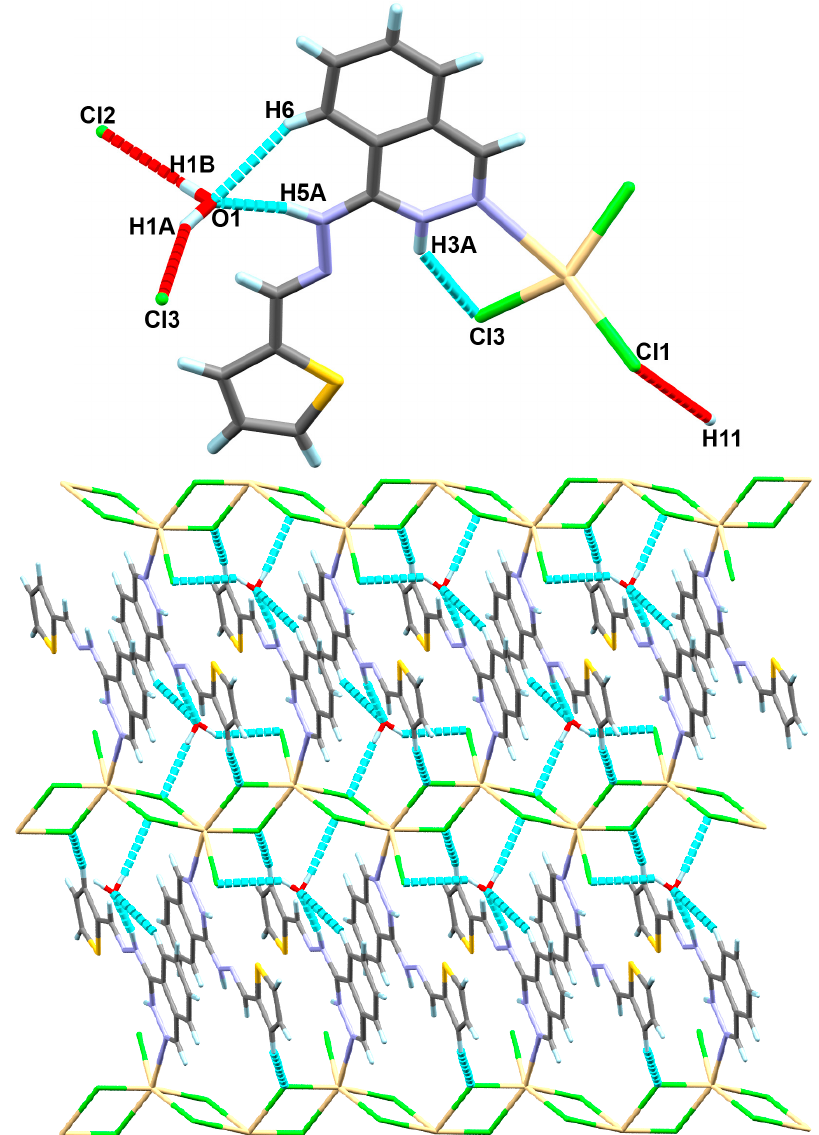
Figure 5. The hydrogen bond contacts ( upper ) and the hydrogen bonding network ( lower ) connect- ing the Cd-Cl chains via the O…H hydrogen